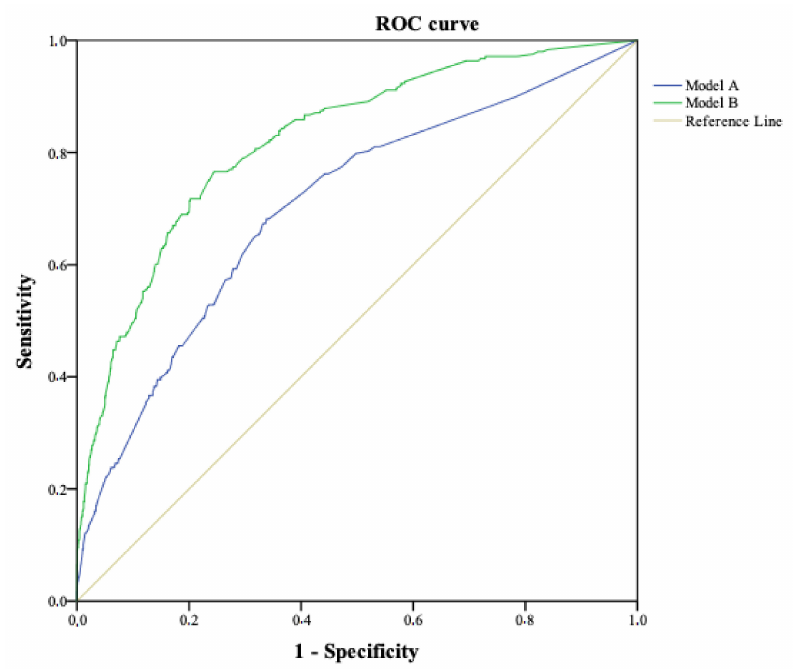
Figure 1. Predictive capacity of model A and model B in the derivation cohort. Area under the ROC curve to determine the predictive ability of the model in the validation cohort, representing the sensitivity on the y axis and 1- specificity in the x